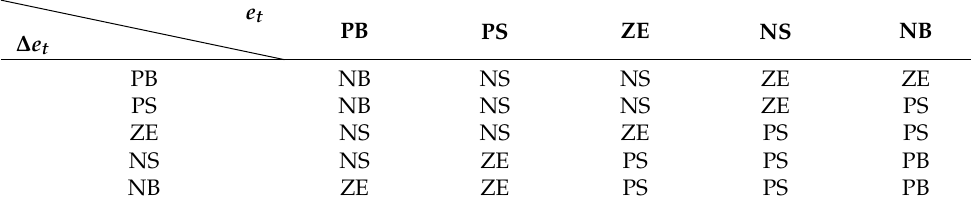
Table 6. Rules for the five-stage fuzzy